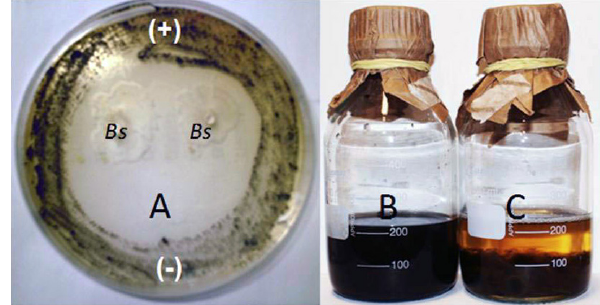
Figure 1. Chestnut-brown pigment secretion after one week of co-culturing F. pedrosoi with B. subtilis . ( A ) Plate co-culture on SDA medium, (+) positive reaction of pigment secretion proximal to bacterial colonies and (–) negative region. ( B ) Flask co-culture on SDB medium without antibiotic. ( C ) Pure culture of F. pedrosoi cultivated for 15 days on SDB medium with antibiotic. Bs : Bacillus subtilis colony.